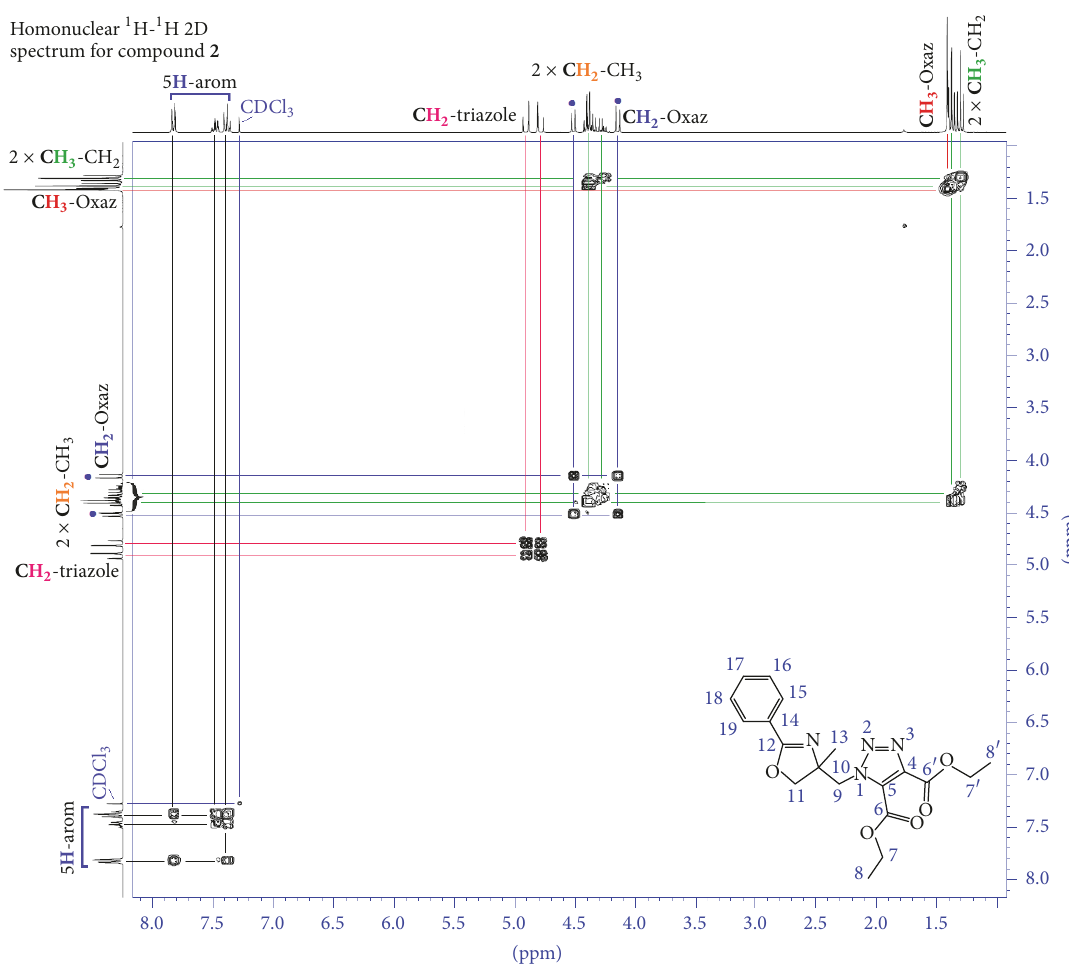
Figure 1: 1 H- 1 H correlation spectroscopy identifies coupling between protons in compound 2